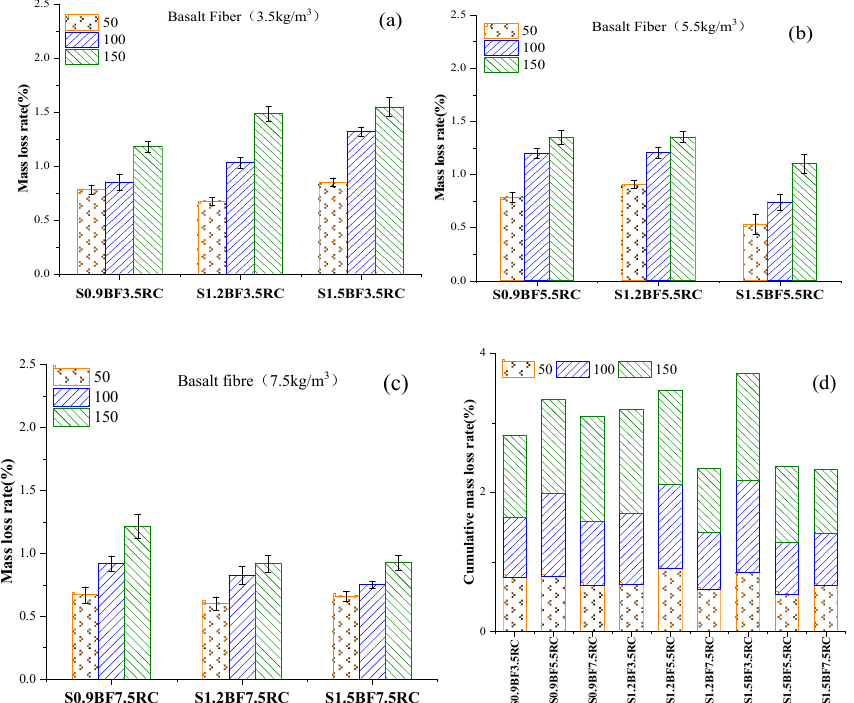
Figure 3. ( a – c ) Mass loss rate of steel – basalt fiber recycled concrete. ( d ) The cumulative mass loss rate.